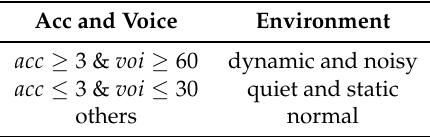
Figure 2. The noise data in different environments. Table 1. Environment